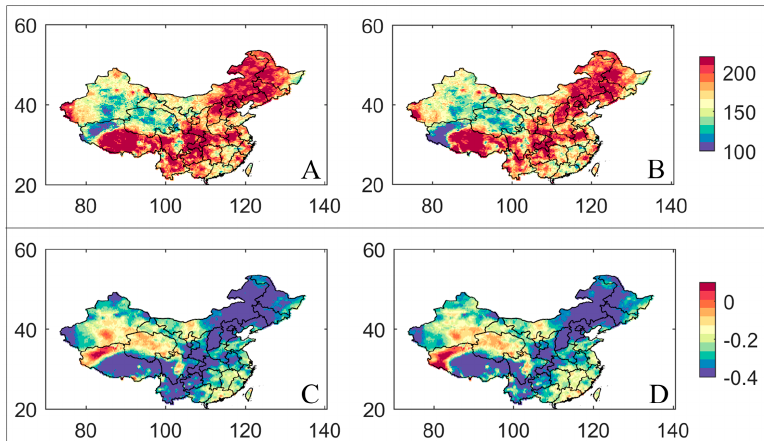
Figure 2. The frequency (days) of compound droughts (SPI) and hot extremes (NHD) based on the threshold SPI < − 0.8 (( A ): SPI3, ( B ): SPI6) and the correlation between SPI and NHD ( C ): SPI3, ( D ): SPI6) over the period 1953–2012 in China.